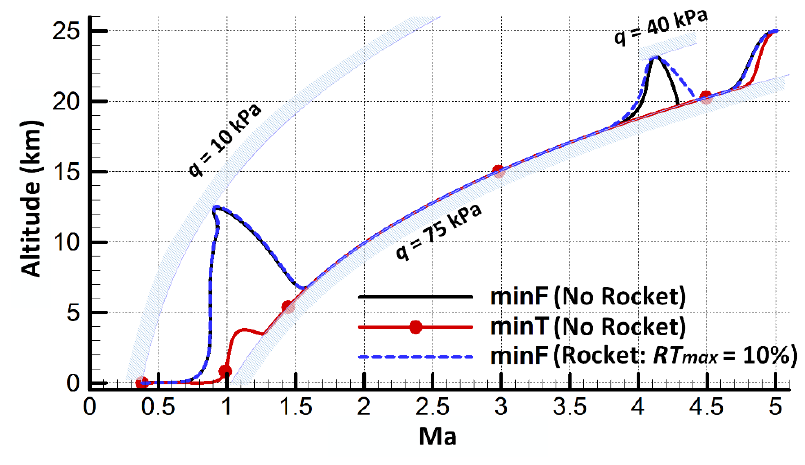
Figure 4. Flight envelopes.